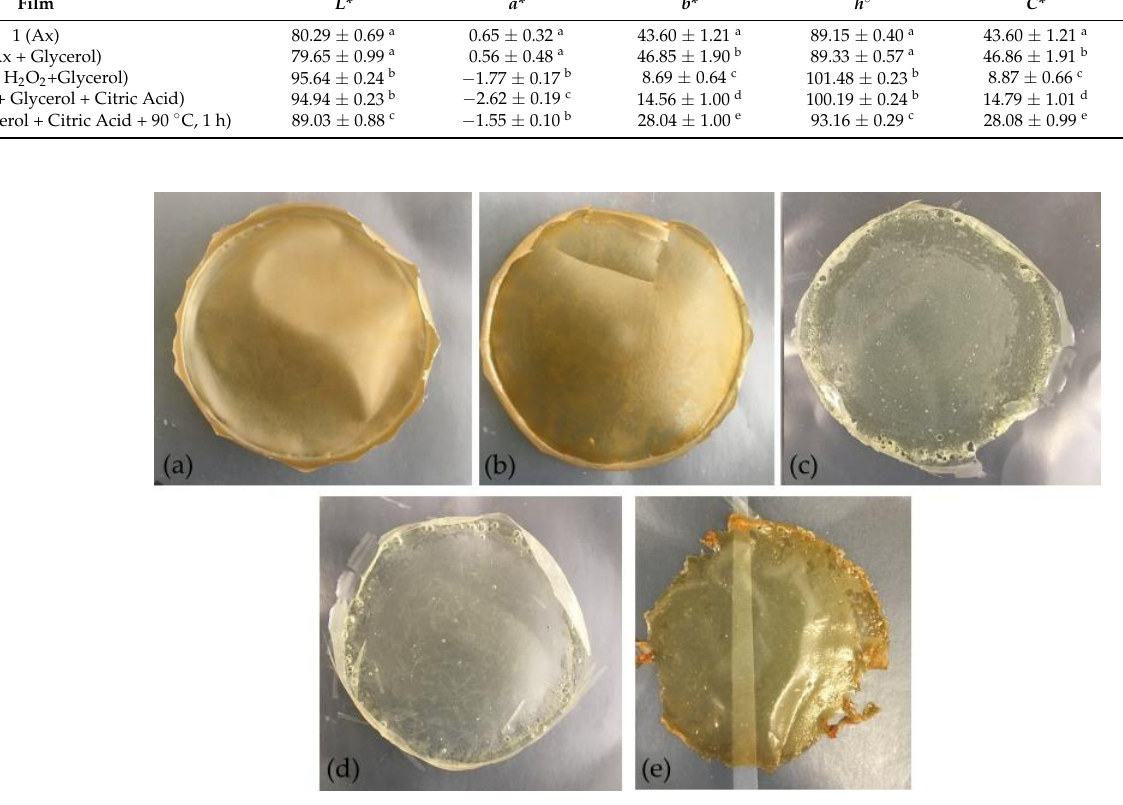
Figure 6. Films based on arabinoxylan (Ax): ( a ) 1 (Ax), ( b ) 2 (Ax + Glycerol), ( c ) 3 (Ax + Glycerol + H 2 O 2 ), ( d ) 4 (Ax + Glycerol + H 2 O 2 + Citric Acid), and ( e ) 5 (Ax + Glycerol + H 2 O 2 + Citric Acid + 90 °C, 1 h).